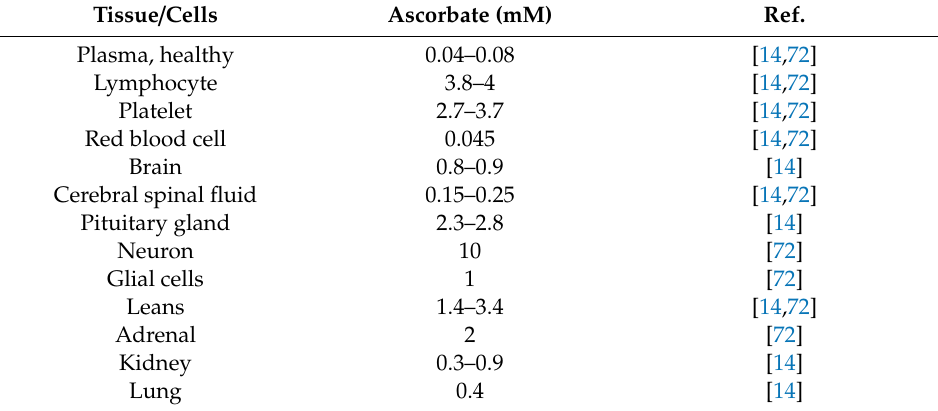
Table 1. Approximate ascorbate concentration in human tissue and cells according to